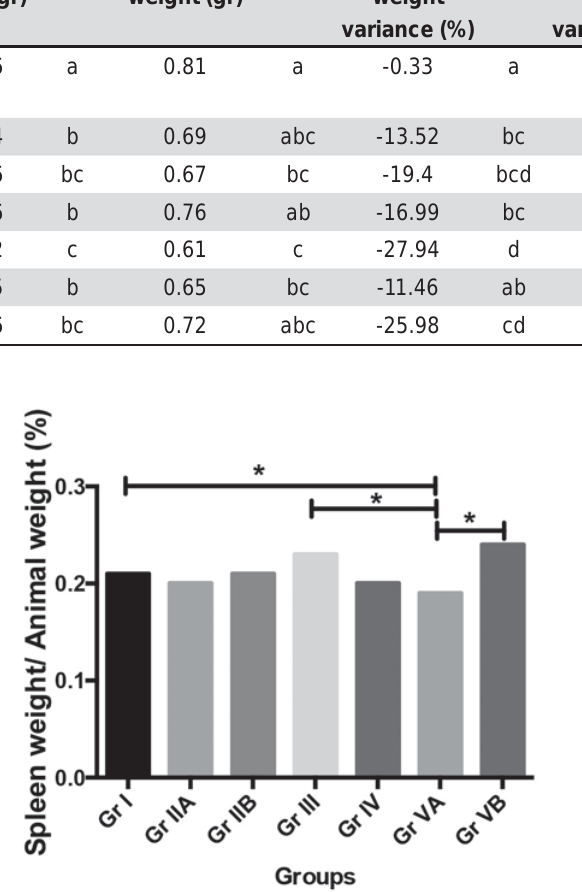
Figure 4- Results of the comparison as a percentage of the ratio of animal and spleen weight. The results are presented